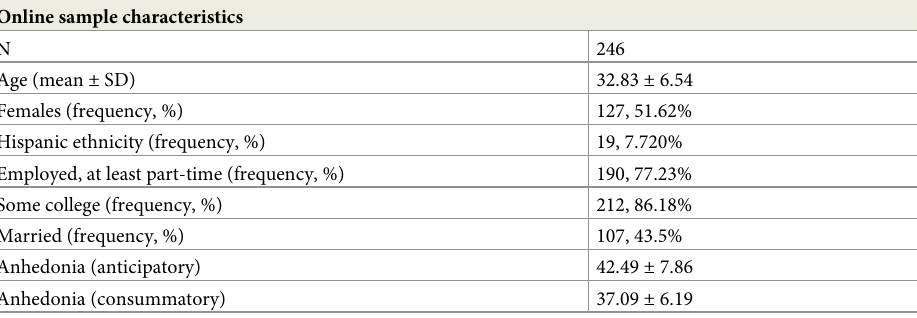
Table 2. Participant characteristics for Experiment